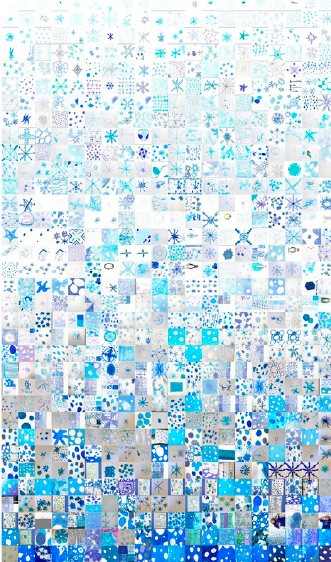
Figure 2. An example of the snow-firn-ice profile, or “global ice core” generated from the global submissions. Image created by the author Heidi Roop in collaboration with Dan Zwartz.